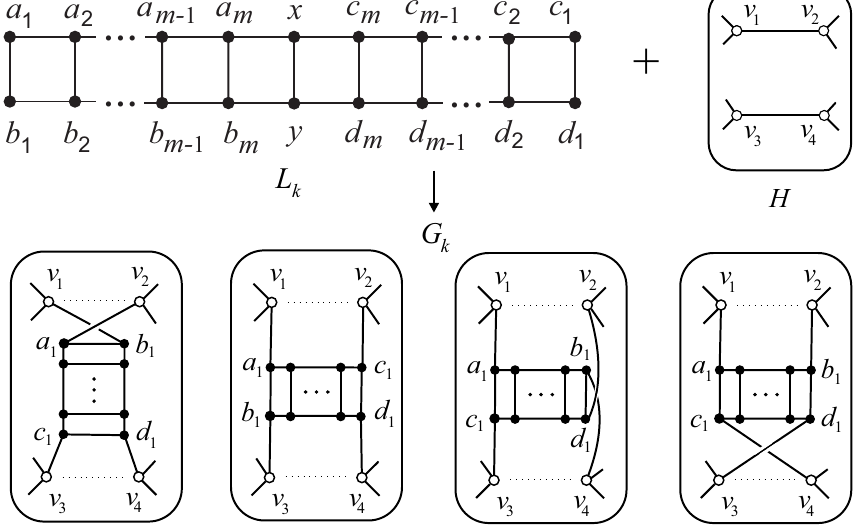
Figure 2. Examples of inserting ladder L k into graph H